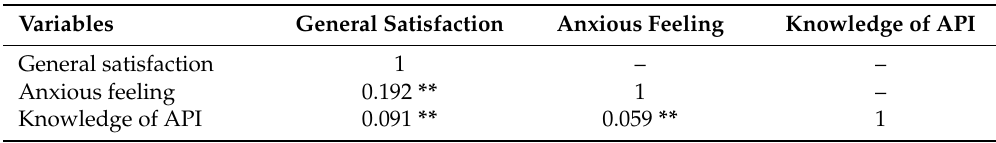
Table 6. Correlation coefficients ( ϕ ) between respondents’ general satisfaction, anxious feeling and knowledge of API toward current air quality.